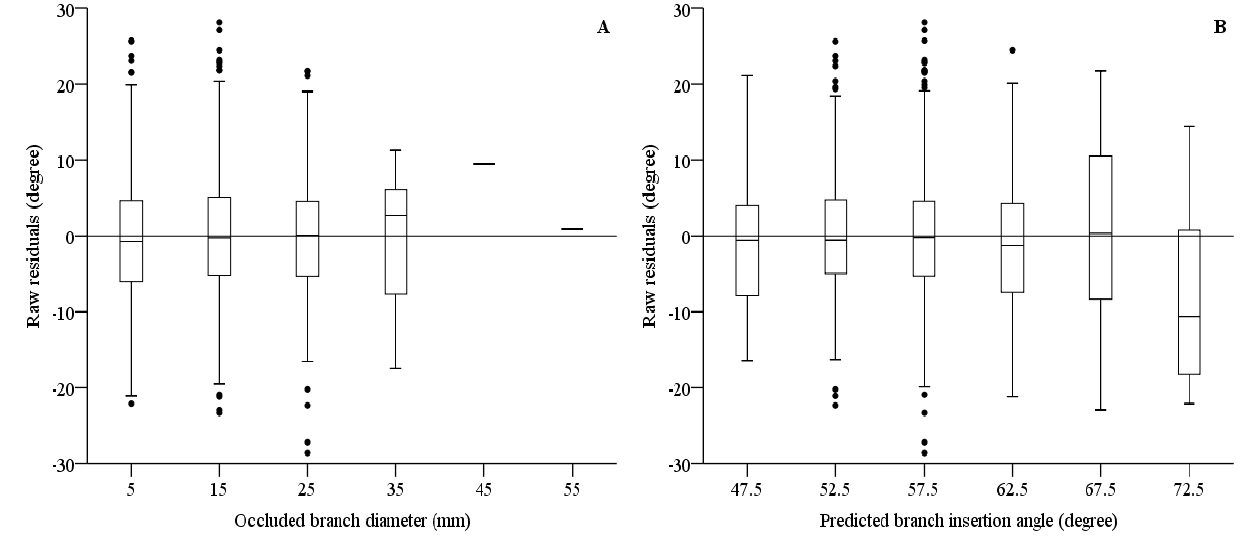
Figure 5. Raw residuals of the model on insertion angel of occluded branch plotted against independent variables ( A ) and predicted ( B ) variables. The edges of the box are 25th and 75th percentiles; the vertical lines are drawn from the box to the most extreme point within 1.5 interquartile ranges; the transverse lines in boxes connect the medians.